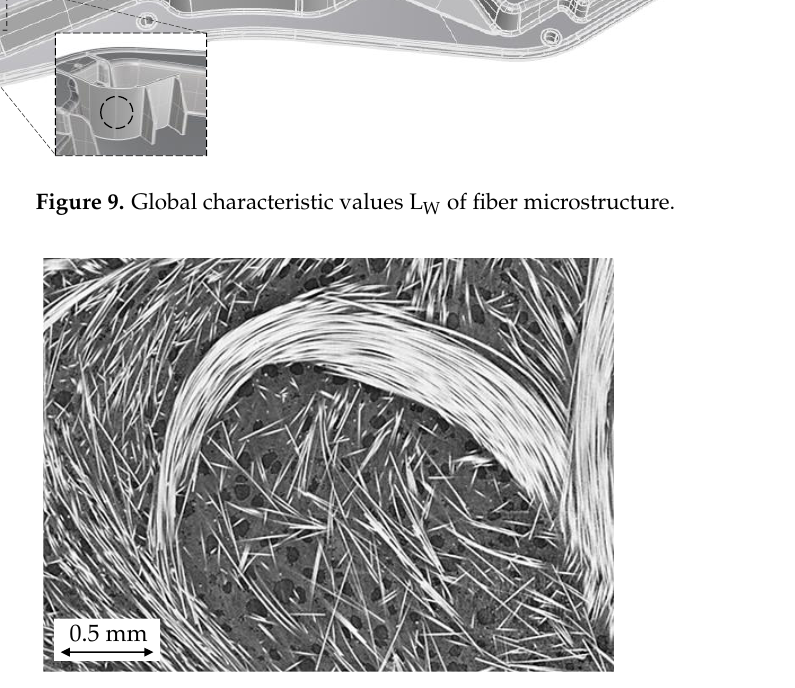
Table 3. Fiber orientation tensors for compact and foamed panels. Compact Panels